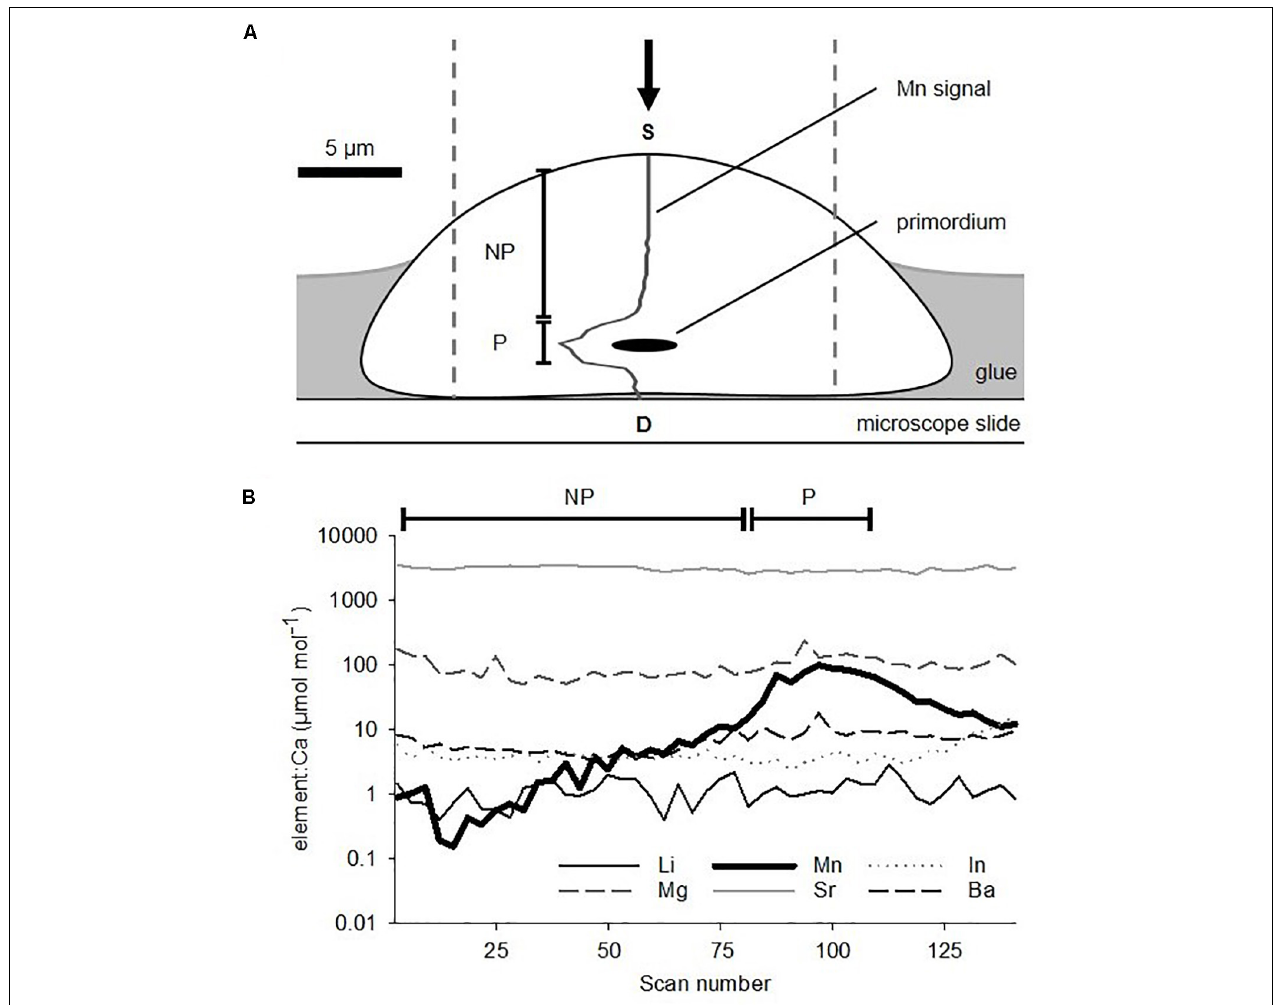
FIGURE 4 | (A) Schematic cross-section of a sagittal otolith from a larval King George whiting mounted sulcus face upward on a microscope slide in preparation for elemental analysis. Dashed lines show the area that the LA-ICP-MS ablation path encompassed. The arrow indicates the direction of laser ablation. 55 Mn signal is overlaid on the otolith. (B) Example of a time-resolved multi-elemental profile for a larval otolith ablated through the primordium from the proximal (S) to distal (D) surfaces. Note the logarithmic scale. NP, non-primordial area; P, primordial